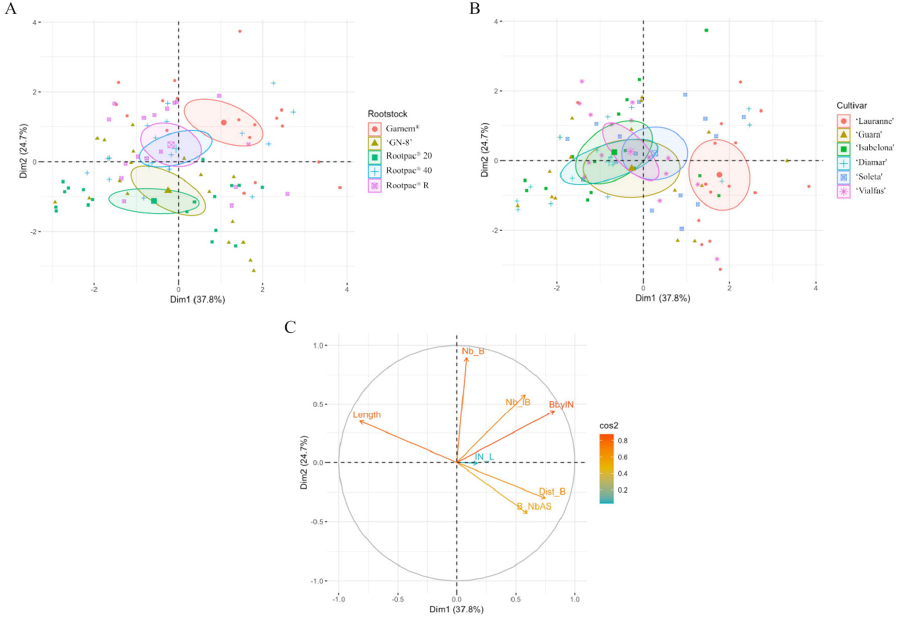
Figure 2. Principal component analysis (PCA) of seven non-redundant variables of 30 almond scion– rootstock combinations. ( A ) Distribution of scion–rootstock combinations classified by rootstock choice as a categorical variable with the first two components (Dim1 and Dim2), with concentration ellipses for each rootstock; ( B ) Distribution of scion–rootstock combinations classified by cultivar choice as a categorical variable with the first two components (Dim1 and Dim2), with concentration ellipses for each cultivar; ( C ) Distribution of the seven non-redundant variables with the first two components (Dim1 and Dim2). Contribution of each parameter to the components is colored from blue to red. Data were collected from 2-year-old trees. Refer to Table 1 for